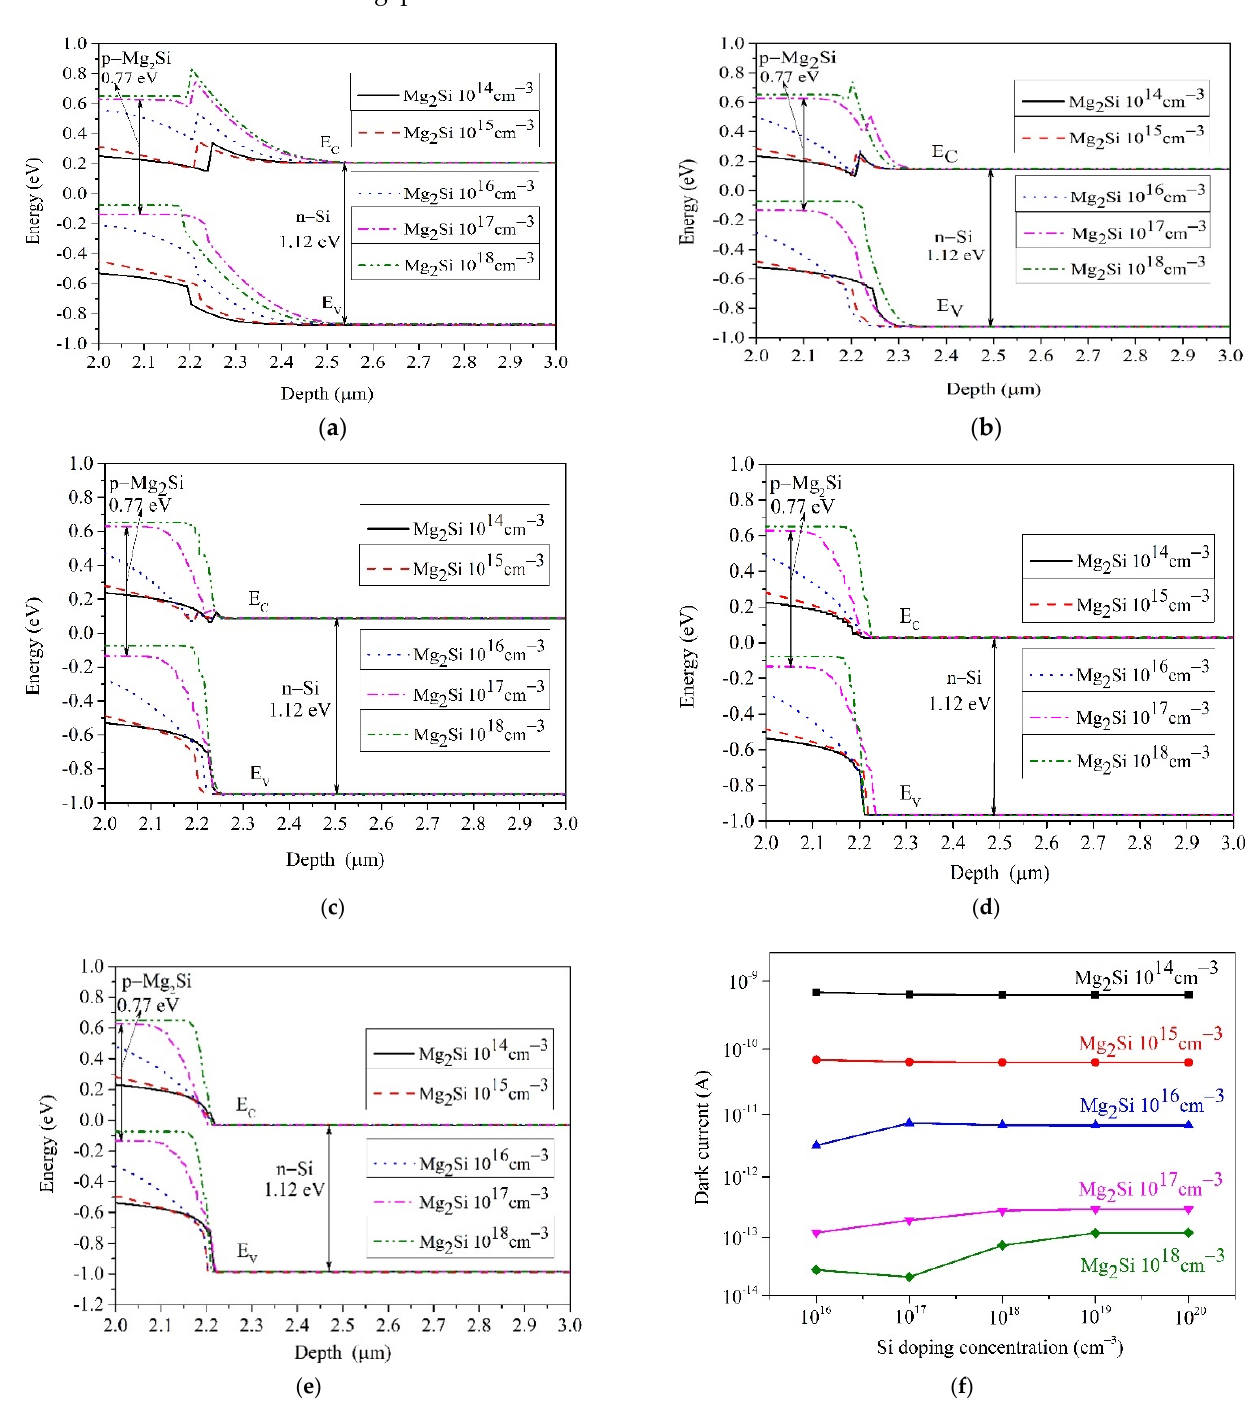
Figure 3. The energy bands of the heterojunction PDs at different doping concentrations. ( a ) Si–10 16 cm − 3 . ( b ) Si–10 17 cm − 3 . ( c ) Si–10 18 cm − 3 . ( d ) Si–10 19 cm − 3 . ( e ) Si–10 20 cm − 3 . ( f ) The effect of doping concentrations on dark current.